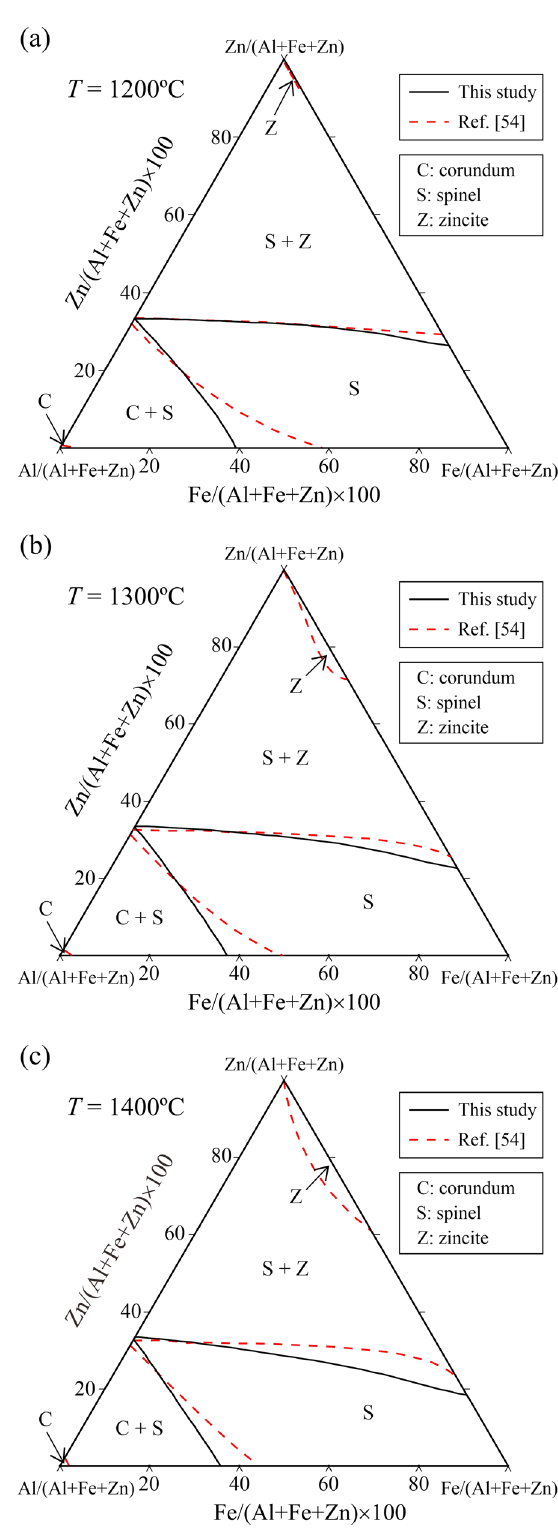
Figure 4: Calculated isothermal phase equilibria of the Al 2 O 3 – FeO – Fe 2 O 3 – ZnO region projected onto the Al – Fe – Zn ternary composition triangle in air at ( a ) T = 1,250°C, ( b ) T = 1,400°C, and ( c ) T = 1,550°C, together with the experimental results [ 27 ] .